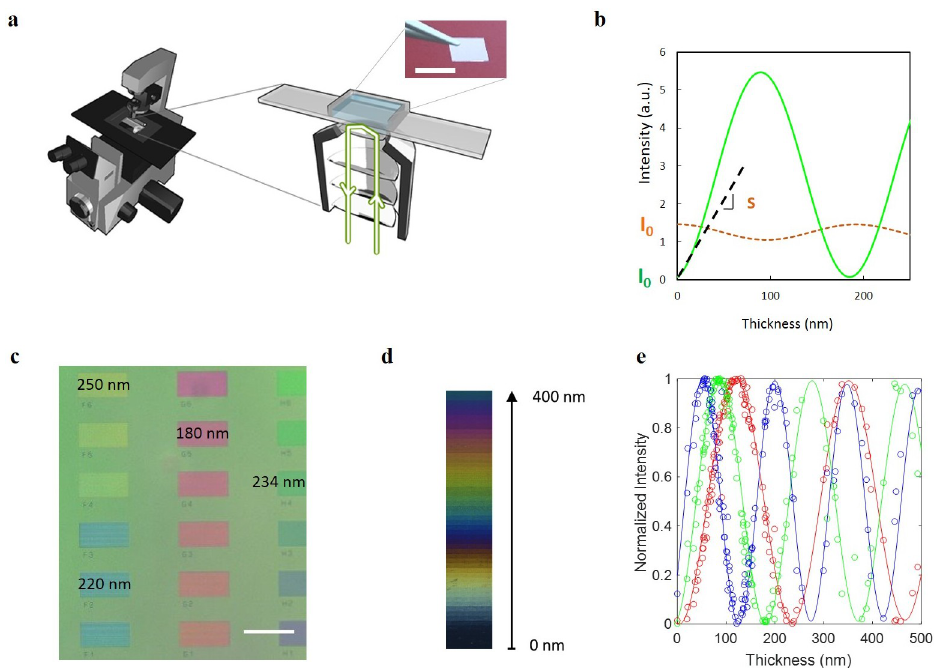
Fig 1. Wet-SEEC set-up, principle, calibration and measurement. (a) Schematics of a Wet-SEEC set up: observations on an immersed wet-surf (insert) are made in reflection mode with a standard inverted microscope. Scale bar 1 cm. (b) Theoretical reflected intensity for a layer of optical index n = 1.5 and wavelength λ = 546 nm versus Layer the layer thickness on a glass slide (dashed orange line) and on a wet-surf (green line). (c) Widefield Wet-SEEC image of a resin steps calibration sample. The sample is illuminated with a white source coupled to a triple-wavelength bandpass filter and the image is taken with a x20 objective. Scale bar 50 μ m. (d) Color scale composed of cropped Wet- SEEC images of many resin steps with different thicknesses. Images were taken with a x63 oil objective and recorded for three wavelengths. Each individual image is a merge of images recorded with three wavelengths λ = 432 nm, λ = 546 nm, and λ = 645 nm. Thickness scale is indicated by black arrow. (e) Modeling of the optical signal. Experimental (open circles) and theoretical (solid line) intensities of thin resin films of different thickness on a wet-surf after normalization by the experimental and theoretical I min and I max values (Eq 2). Calculations correspond to layers of refractive index 1.49 at wavelengths λ = 432 nm (blue), λ = 546 nm (green), and λ = 645 nm (red) without any adjusting